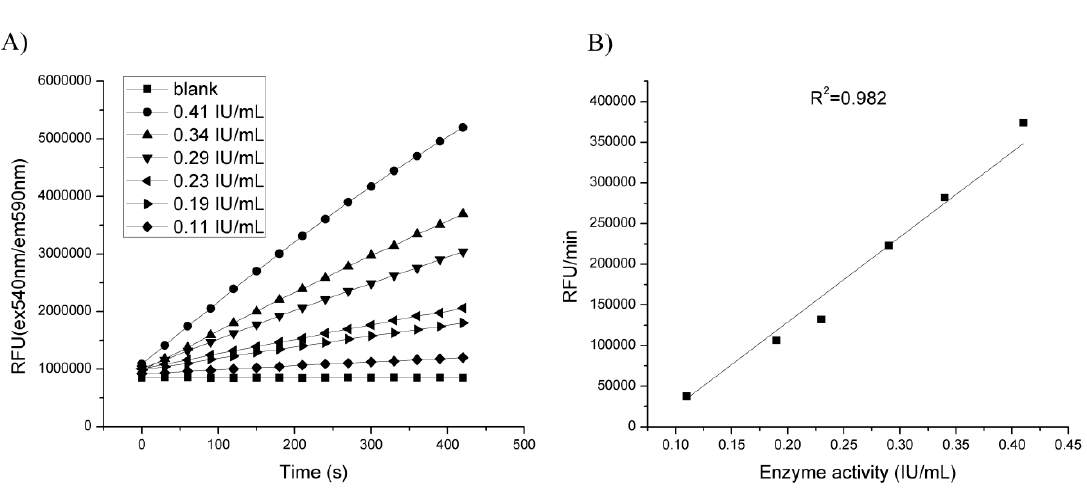
Figure 3. Dependence of fluorescence signal (RFU/min) on ( A ) lactose ( B ) cellobiose concentration in 0.1 M sodium phosphate buffer pH 5.5 with 0.1 mM resazurin and 0.29 IU/mL of CDH enzyme. Fluorescence measured at ex/em 540/590 nm .